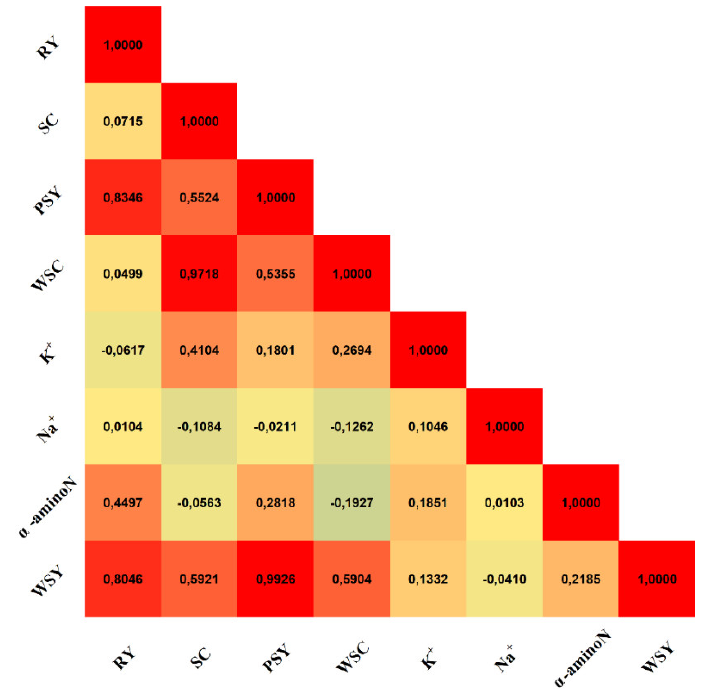
Figure 9. Relationships among sugar beet production traits.